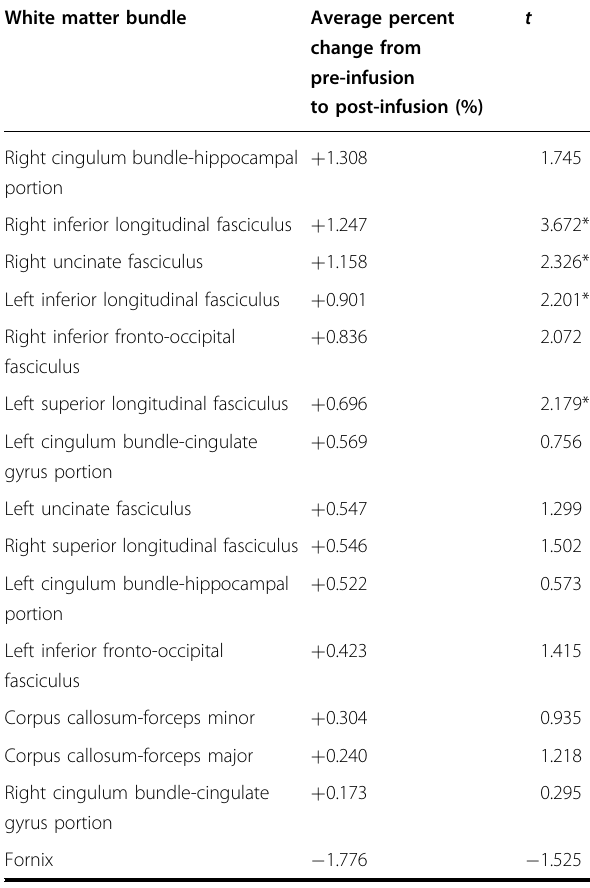
Table 2 Average pre-infusion to post-infusion percent change in white matter bundle